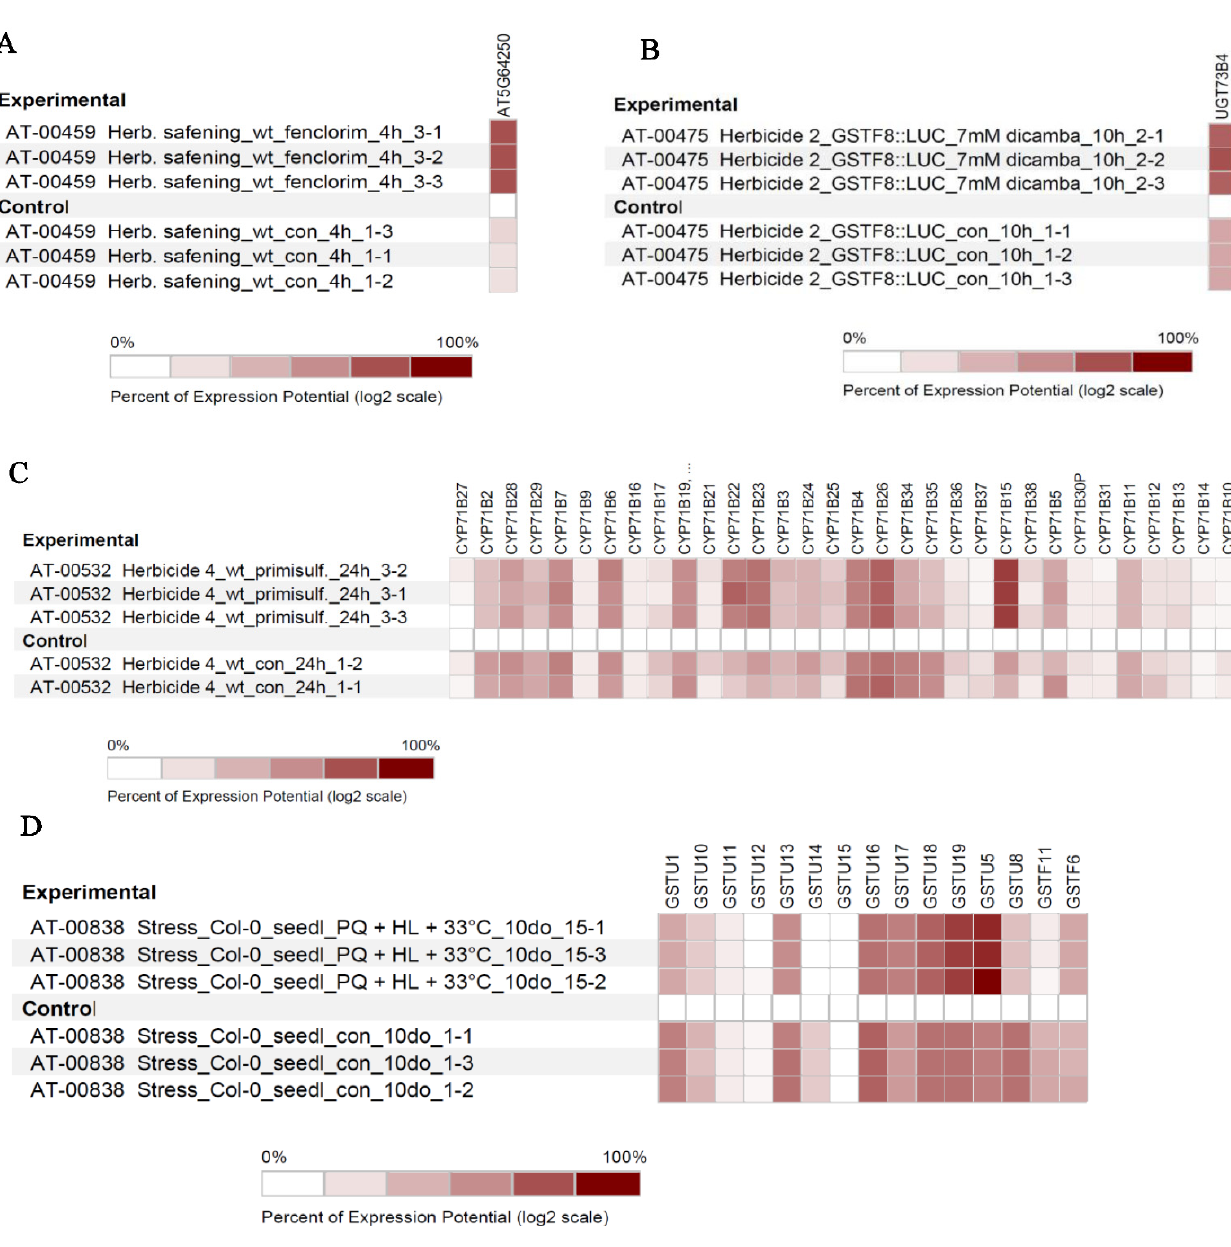
Figure 6. Heatmap-list view of the expression profile of NTSR gene under herbicide stress using the Genevestigator software NMO affymetrix Arabidopsis expression analysis with response to herbicide safener fenclorim ( A ), UGT73B4 affymetrix Arabidopsis expression increases proportionally in the presence of herbicide dicamba when compared with control ( B ), CYP45071 sub-family affymetrix Arabidopsis expression study due to the presence of herbicide primisulfuron (sulfonylurea) ( C ), and GST affymetrix Arabidopsis expression study when plants were exposed to herbicide paraquat ( D ). The level of expression is provided in the log2 scale. The details of the experiments are provided in Supplementary Table S3.